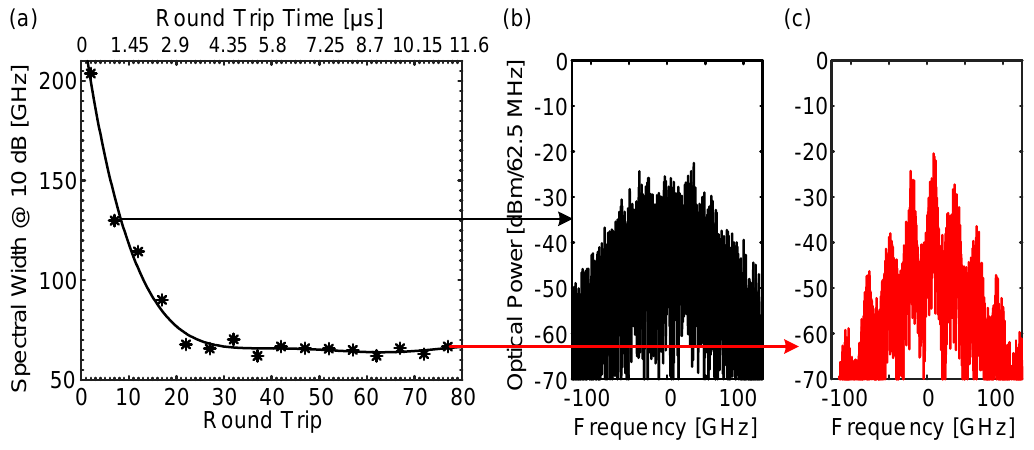
Figure 6. Spectral width evolution of an RSOA-FCL. The insets show the simulated spectra before and after the spectrum